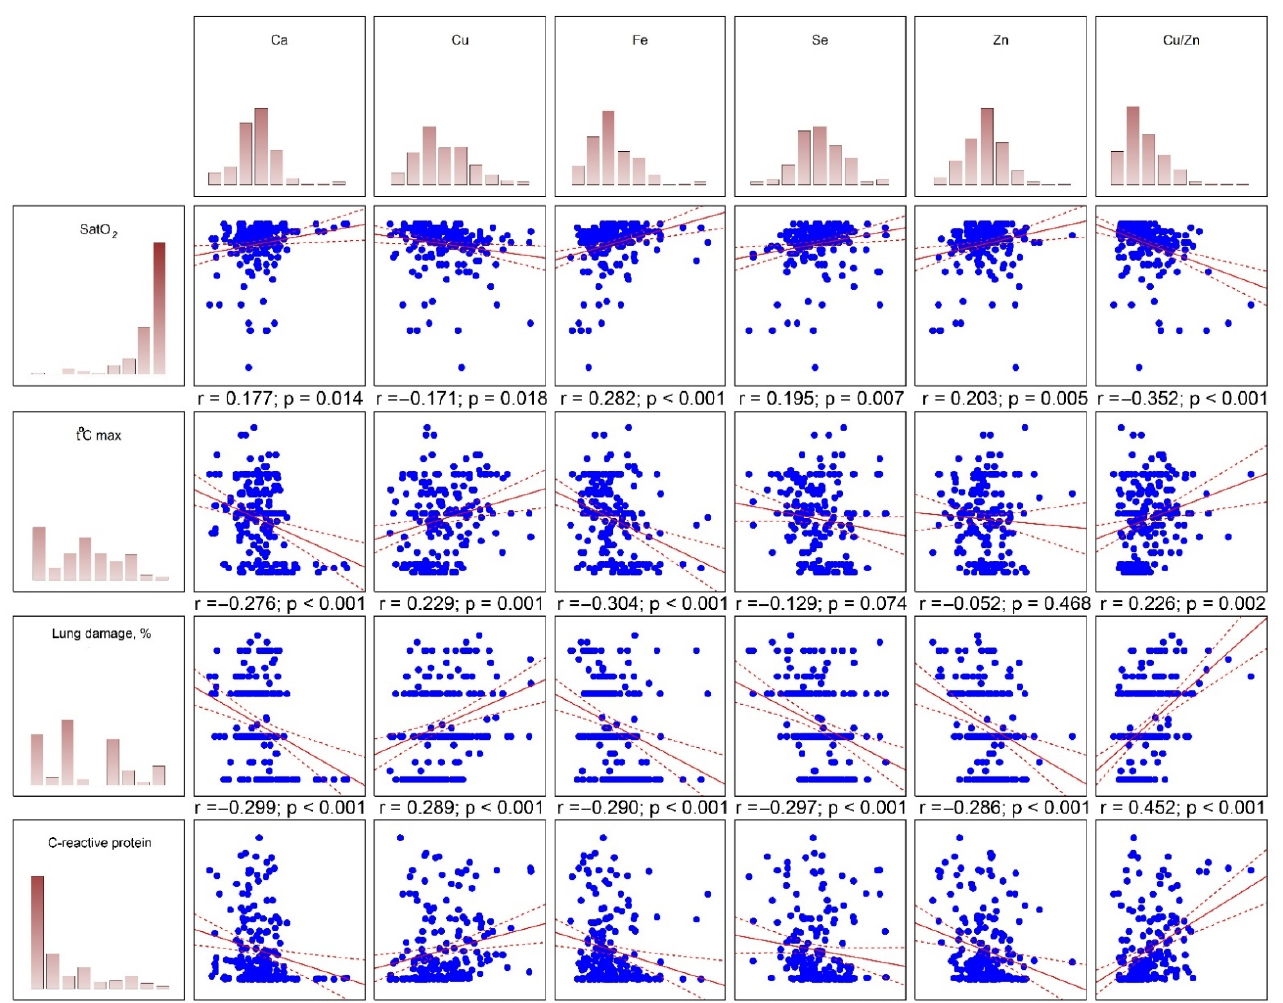
Figure 2. Correlation between serum metal levels and markers of disease severity. Multiple linear regression analysis was performed in order to specify the association between serum metal levels and markers of disease severity, SpO 2 (Table 3) and lung dam- age (Table 4) as dependent variables. Table 3. Multiple regression analysis of the association between blood oxygen saturation (SpO 2 ) (dependent variable) and serum metal levels (Model 1) after adjustment for anthropometric and clinical variables (Model 2), and biochemical and hemostatic markers (Model 3).